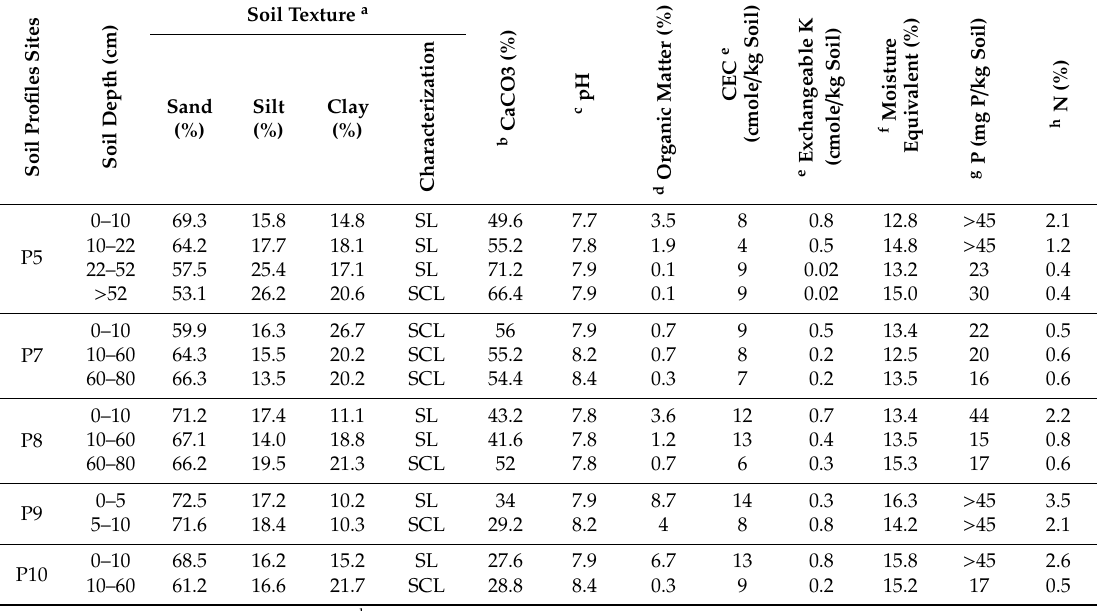
Table A13. Soil analyses of the 14 soil samples of the 5 soil profiles of the 1976 mapping